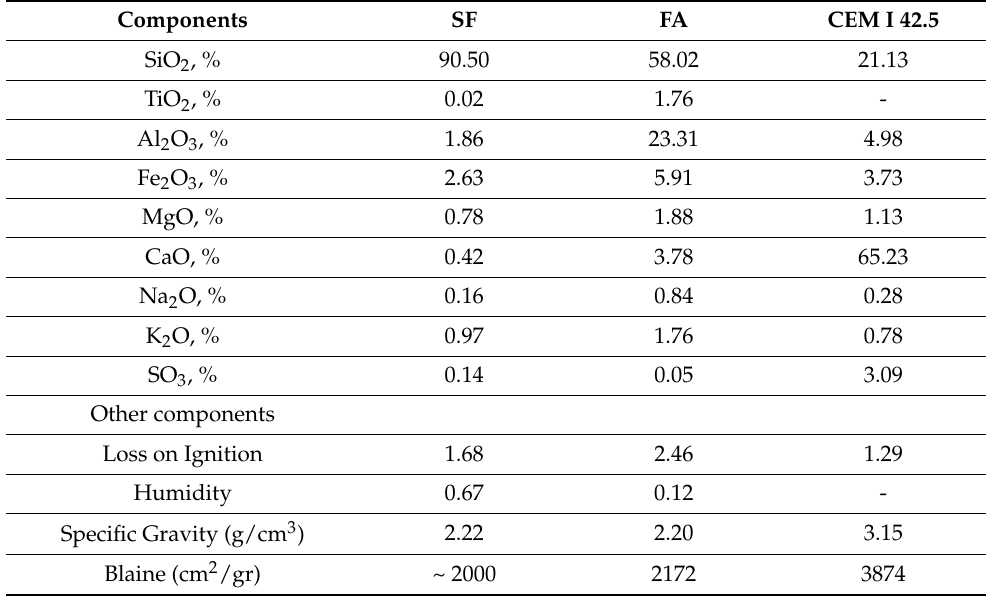
Table 3. Physical and chemical analysis results of the materials.